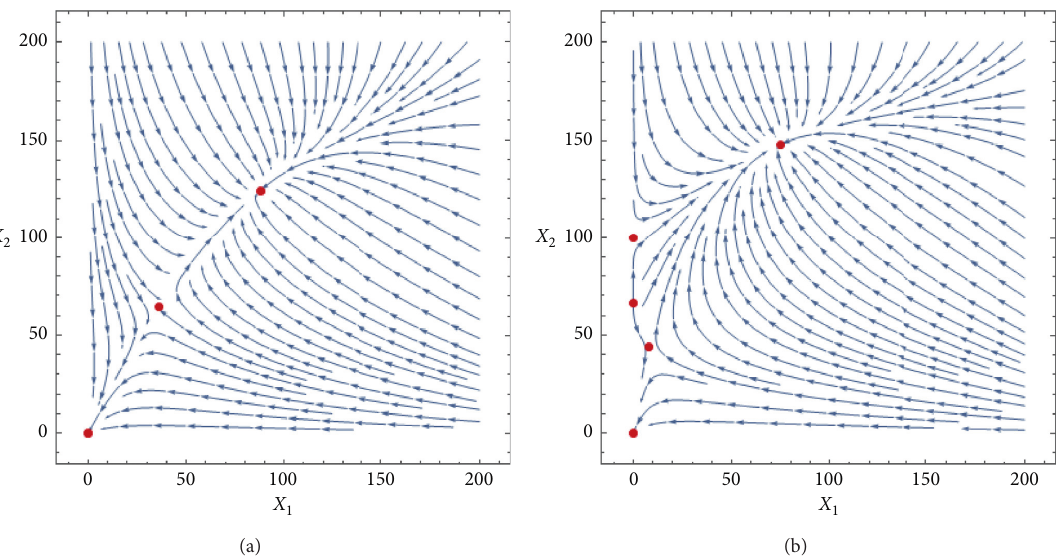
Figure 10: Obligate-obligate mutualism with positive and negative intraspecific interaction: (a) we have the case where b b � 0 . 002, which means that intraspecific competition of X 22 lower than mutualism; (b) we have b mutualism and intraspecific cooperation of X